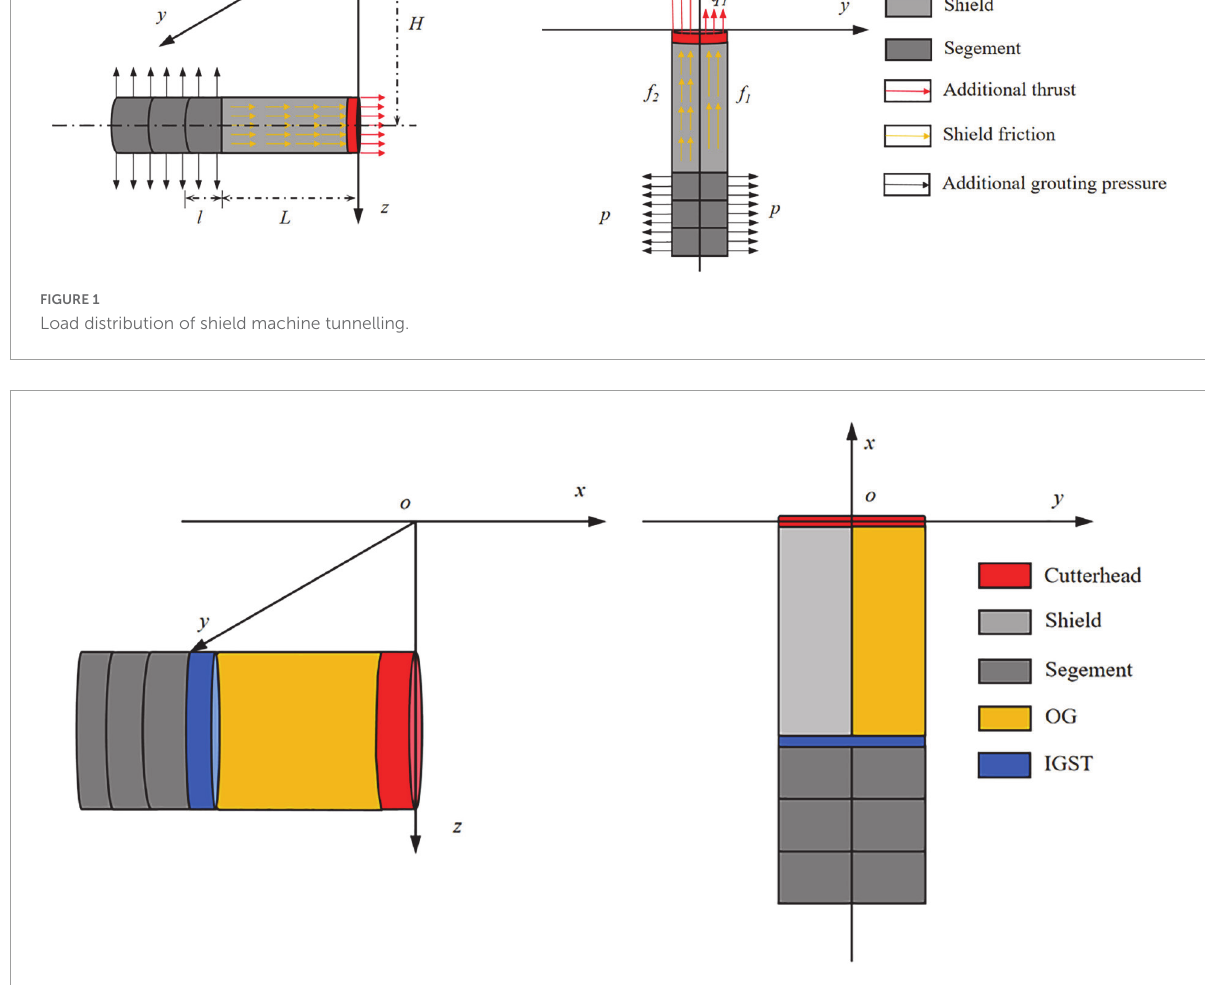
FIGURE2 Distribution of ground loss in the curve